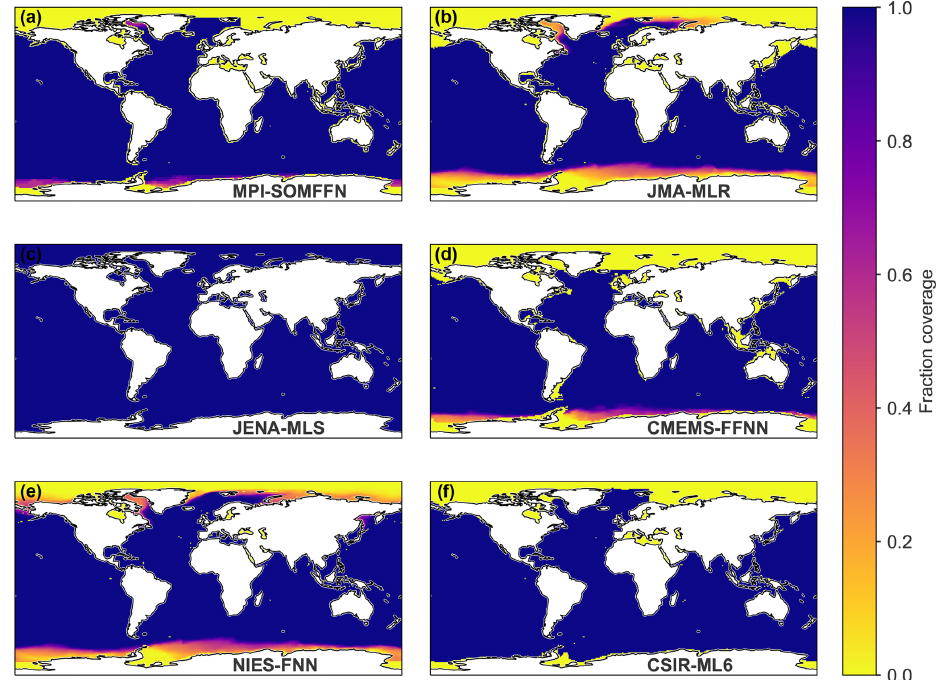
Figure 1. Maps showing the fraction of months (1990–2019) with coverage available for each of the six p CO 2 data products used in this study. Blue regions represent full temporal coverage of p CO 2 in the product, while yellow areas show regions with no reported p CO 2 values for any month of the time series.